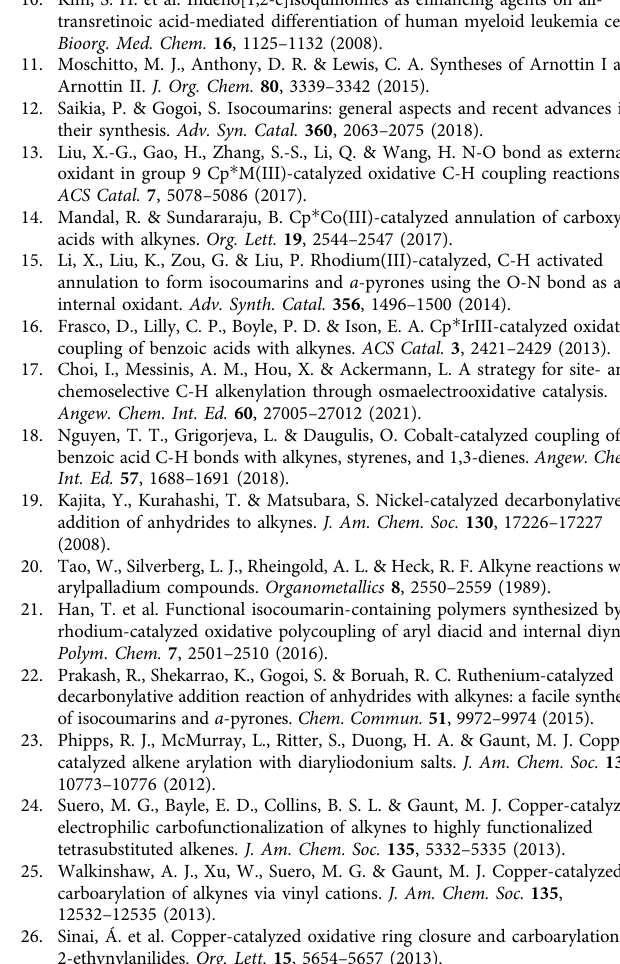
The data supporting the fi ndings of this study are available within this article and its Supplementary Information and Supplementary Data 1.